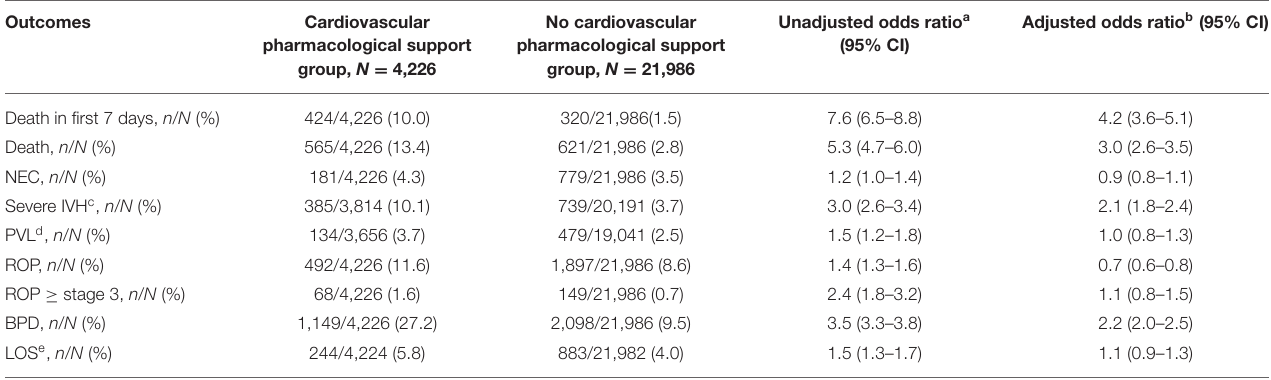
TABLE 2 | Outcomes of infants and cardiovascular pharmacological support. Outcomes